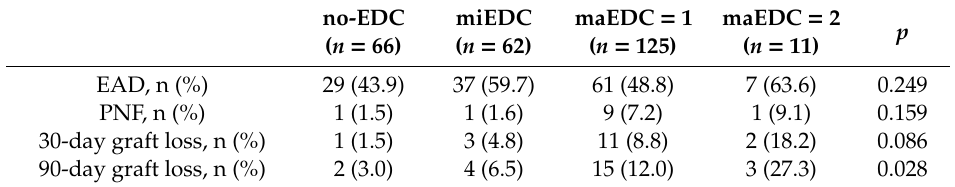
Table 2. Graft loss following liver transplantation in patients with hepatocellular carcinoma